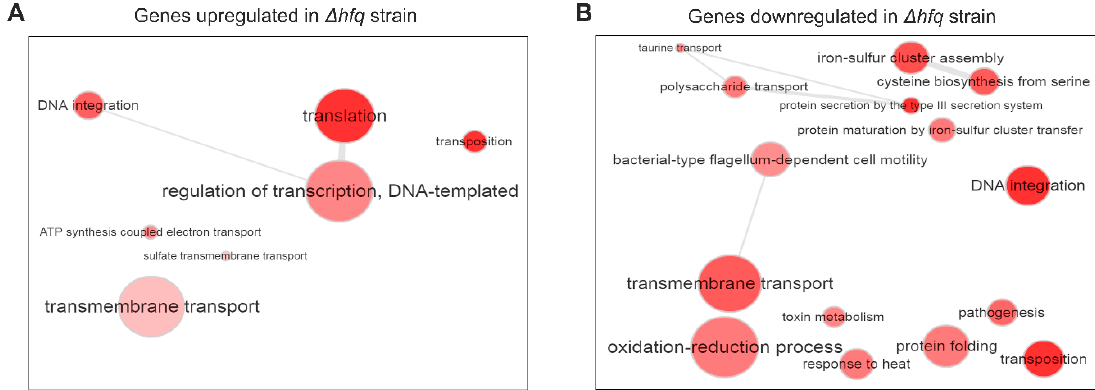
Figure 2. Gene ontology (GO) term analysis of genes significantly downregulated ( A ) or upregulated ( B ) in the ∆ hfq mutant. Significantly enriched terms from the domain ‘Biological processes’ and their catenations are summarized and visualized by REVIGO as an interactive graph. Circle size encodes number of genes associated with respective category and red shades encode the significance level of the